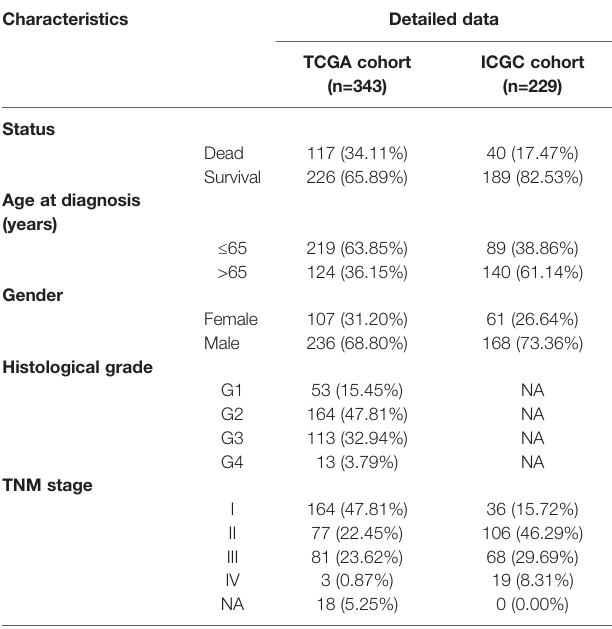
TABLE 1 | The clinical Characteristics of HCC patients from TCGA and ICGC database. Characteristics Detailed